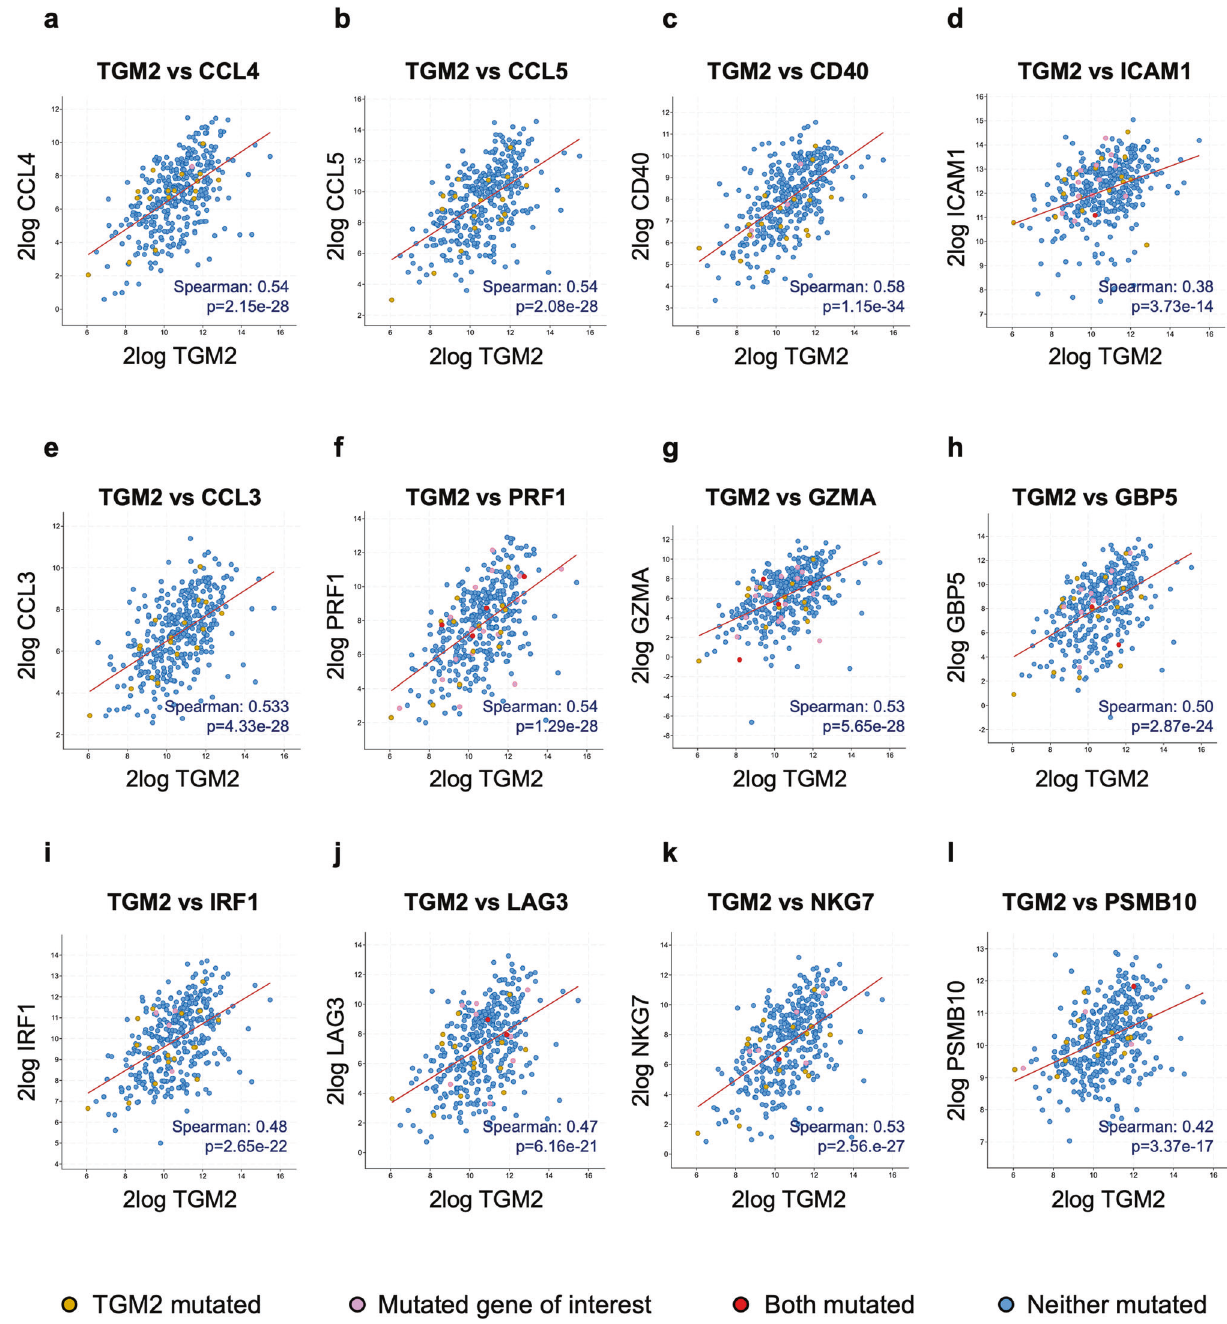
Fig. 5 TGM2 correlation with immune activation markers. a − l Two Pearson correlation analysis between TGM2 level of expression and immune activation markers were obtained from cBioPortal using the SKCM TCGA PanCancer Atlas dataset. Data were plotted as scatter plot based on the Spearman Correlation Coef fi cient (363 samples) (* p < 0.05; ** p < 0.01; *** p < 0.001) and strati fi ed as per TGM2 mutations (gold), correlated gene of interest ’ s mutations (pink), absence of mutations (blue), presence of both mutations in the same sample (red). based on 9736 tumors and 8587 normal samples [23]. GEPIA was used to analyze the expression of TGs in SKCM and their effects on survival rate by means of the Kaplan – Meier analysis tool. We divided samples between high and low TGs expression groups according to the median TGs mRNA levels to analyze overall survival (Log2FC cutoff: 1; p -value cutoff: 0.01, group cutoff selected median, cutoff-high (%): 50; cutoff-low (%): 50). UALCAN database analysis To determine the clinical value of TG2 expression level, the UALCAN database (http://ualcan.path.uab.edu) was employed. UALCAN is an